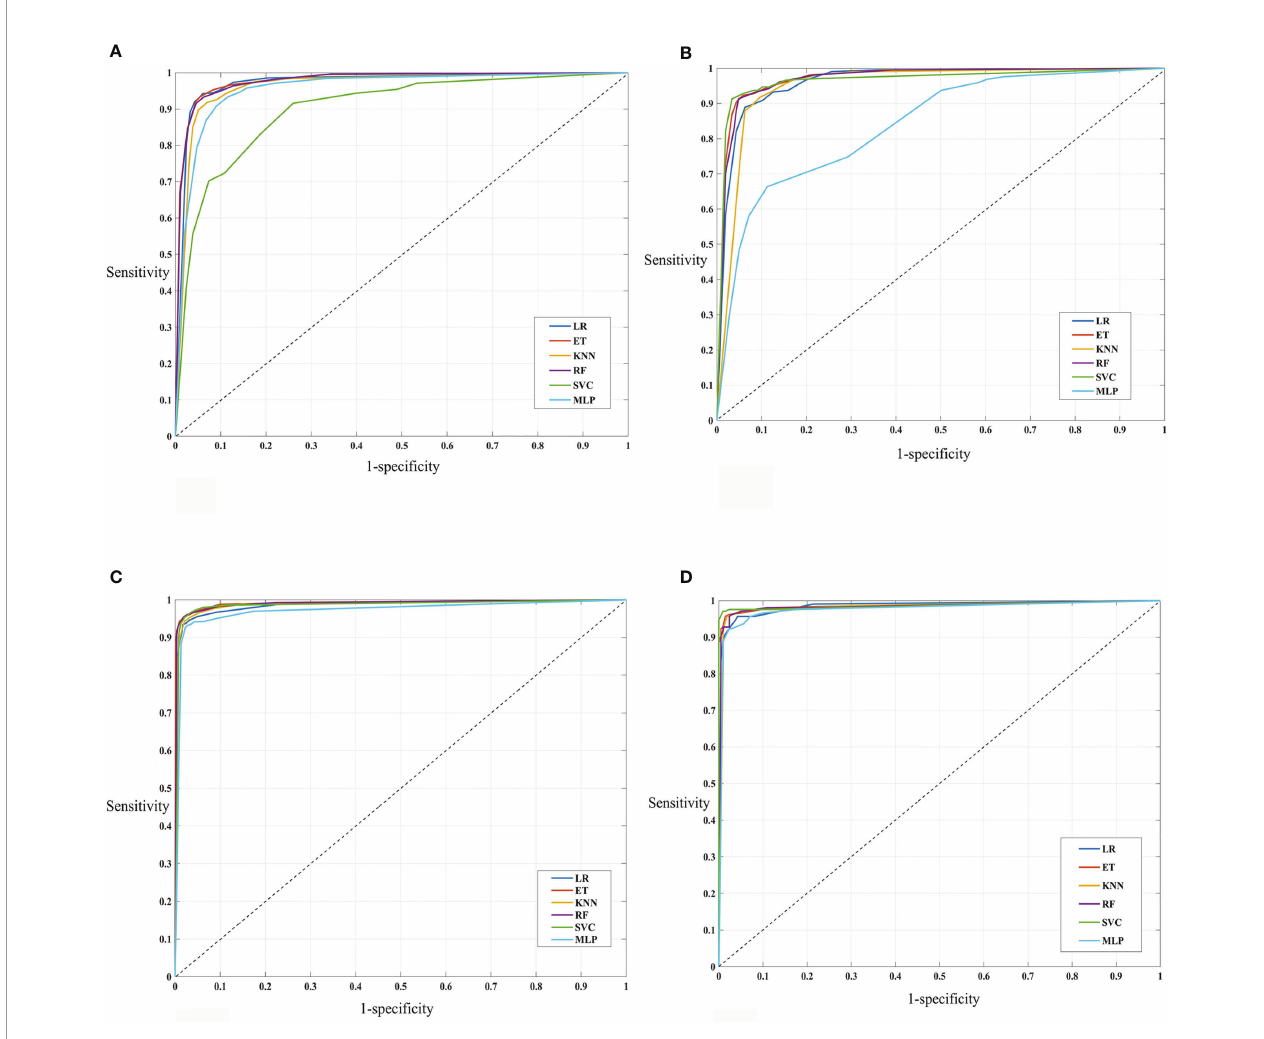
FIGURE 5 | AUROC plots (A) main (top 60 selected features on the training datasets), (B) main (top 60 selected features on the validation datasets), (C) alternate (top 50 selected features on the training datasets), and (D) alternate (top 50 selected features on the validation